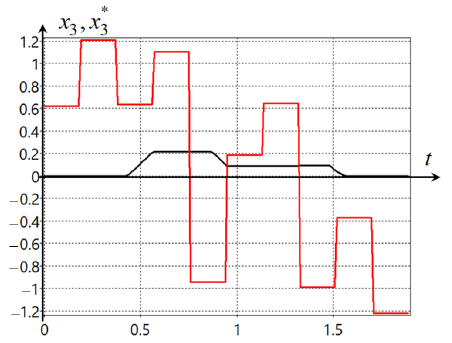
Figure A3. Plots of optimal x 3 and x 3 ∗ .